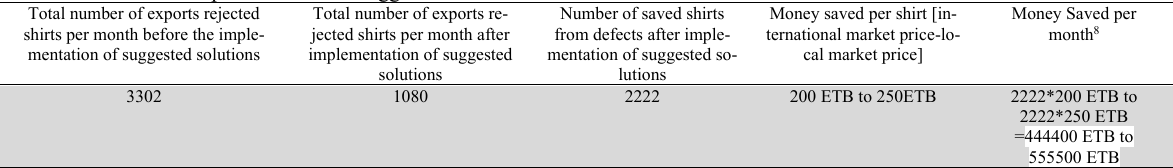
Cost reduction after implementation of suggested solutions Total number of exports rejected shirts per month before the imple- mentation of suggested solutions